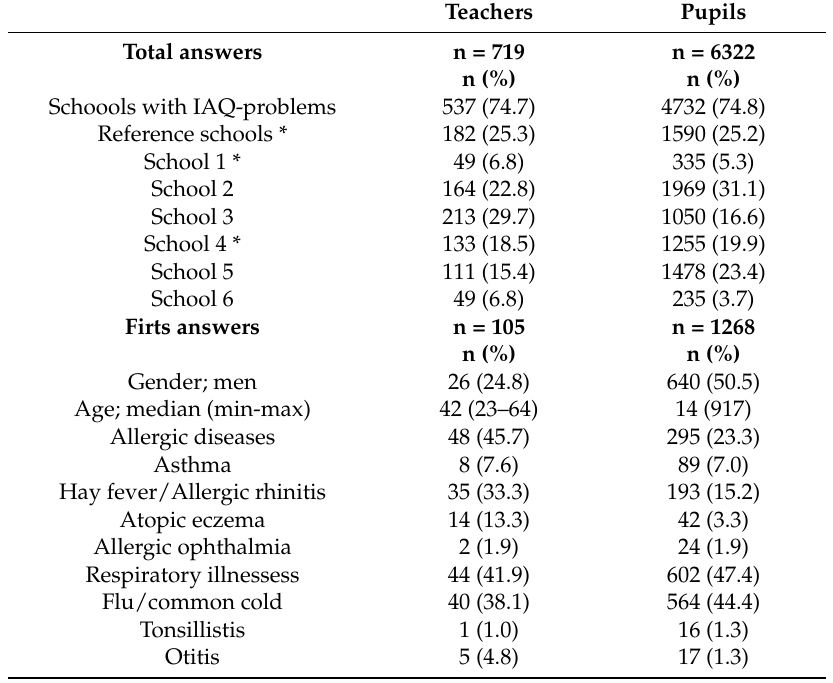
Table 3. Proportion of the responses received from all of the schools, and the background information of the teachers and